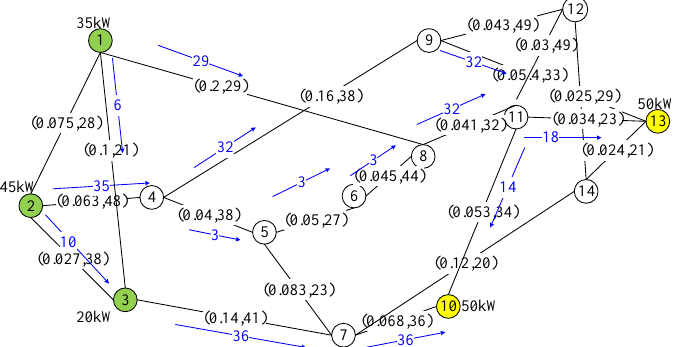
Figure 6. Optimal path selection and source-load matching on the NSFNET network.